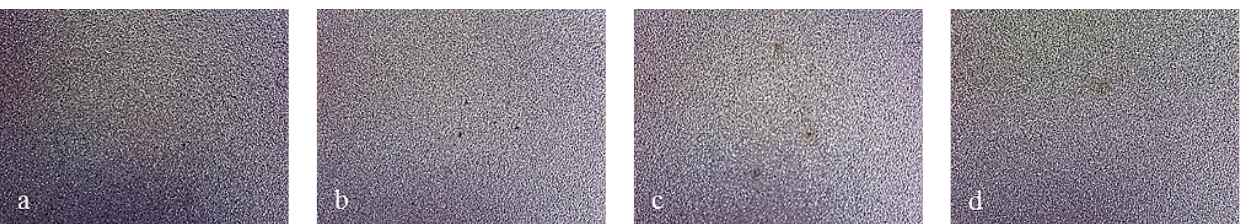
Figure 14. Working area after polarization on X40CrMo15 steel, sandblasted